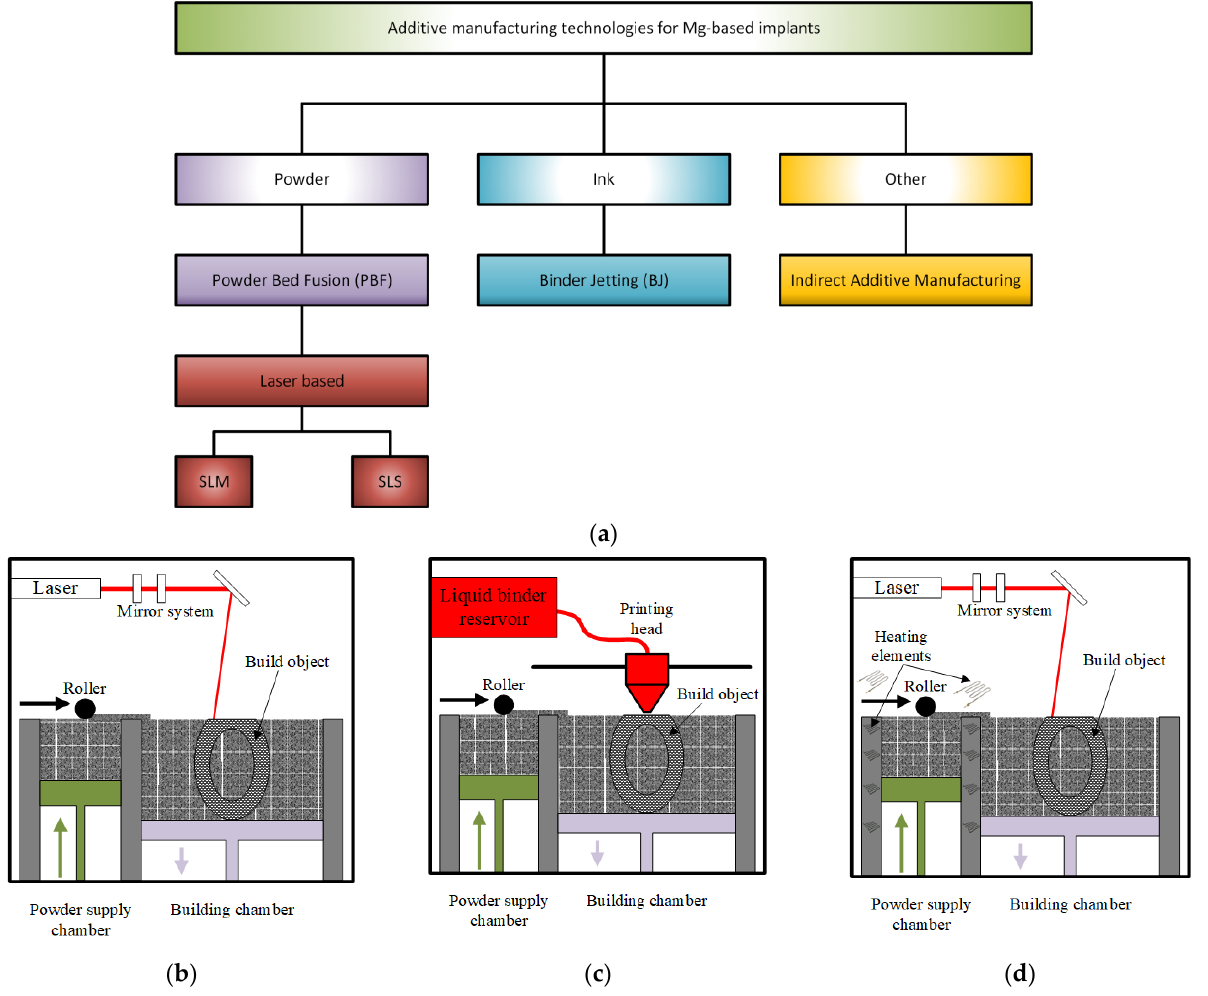
Figure 5. AM technologies used in the Mg- based medical implants’ manufacture: ( a ) schematical representation; ( b ) selective laser melting (SLM); ( c ) binder jetting; ( d ) selective laser sintering (SLS).